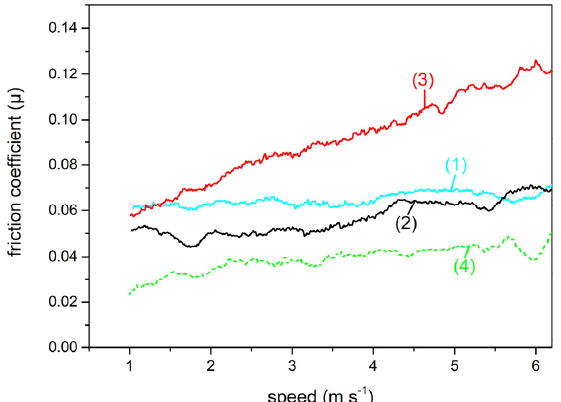
Figure 4. Friction coefficient of bare AISI 301H as a function of the gliding speed on snow at different temperatures: − 10 °C (cyan curve, 1); − 5 °C (black curve, 2); − 3 °C (red curve, 3). For comparison, the µ trend for parallel gliding at − 3 °C of stone grinded and waxed UHMWPE (dashed green curve, 4) is shown.